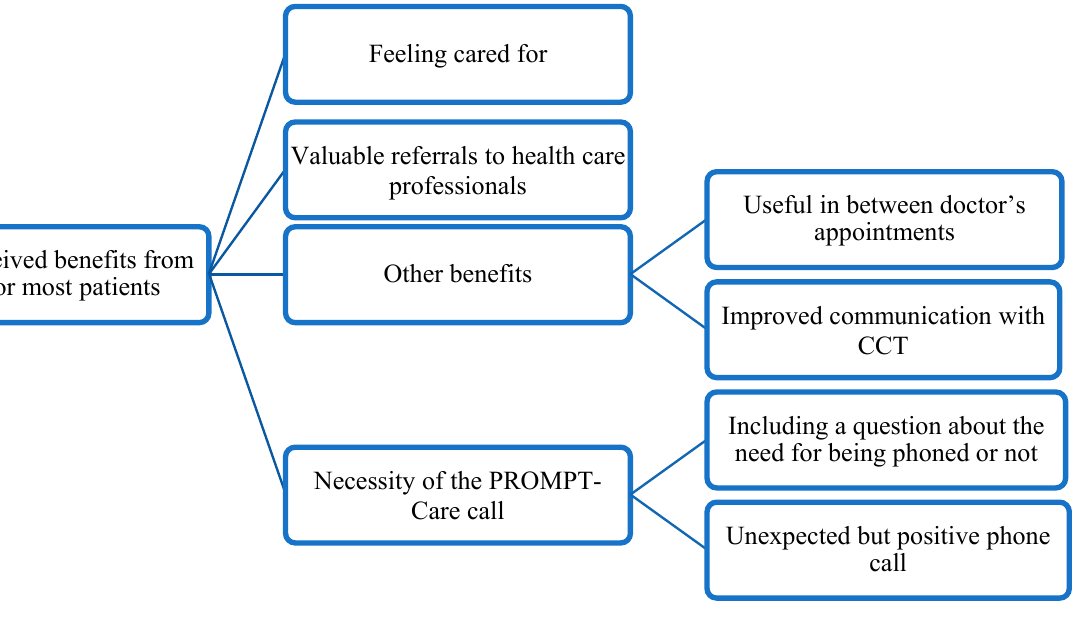
Figure 5. Thematic Figure 5. Thematic map.